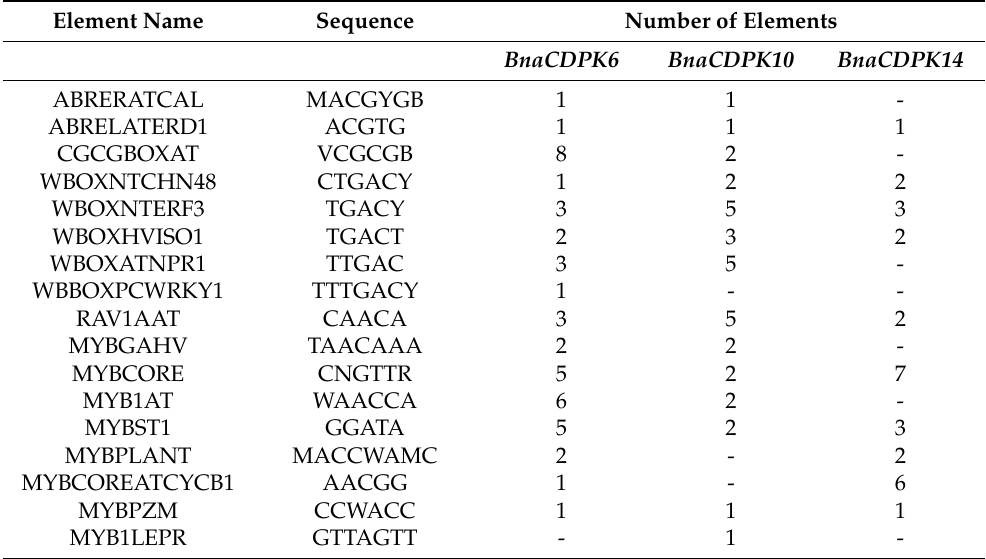
Table 2. Stress-responsive cis elements in the 2000 bp upstream region of BnaCDPK6, BnaCDPK10 and BnaCDPK14 coding